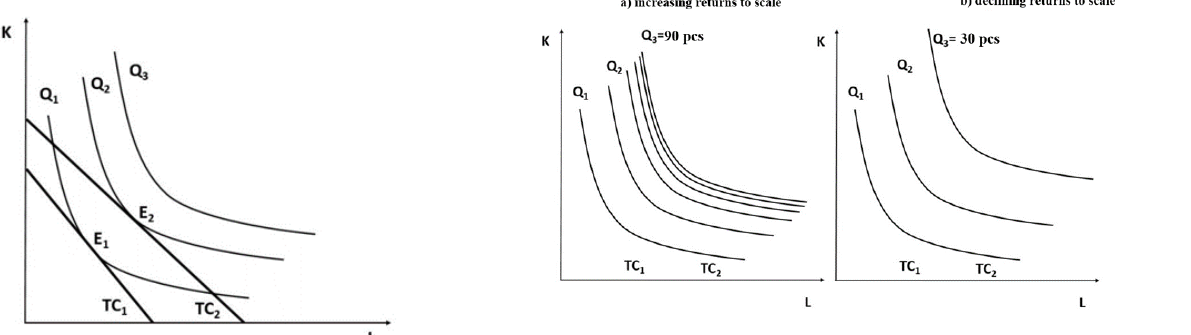
Figure 3: Optimal combination of inputs K and L of the production function Q.